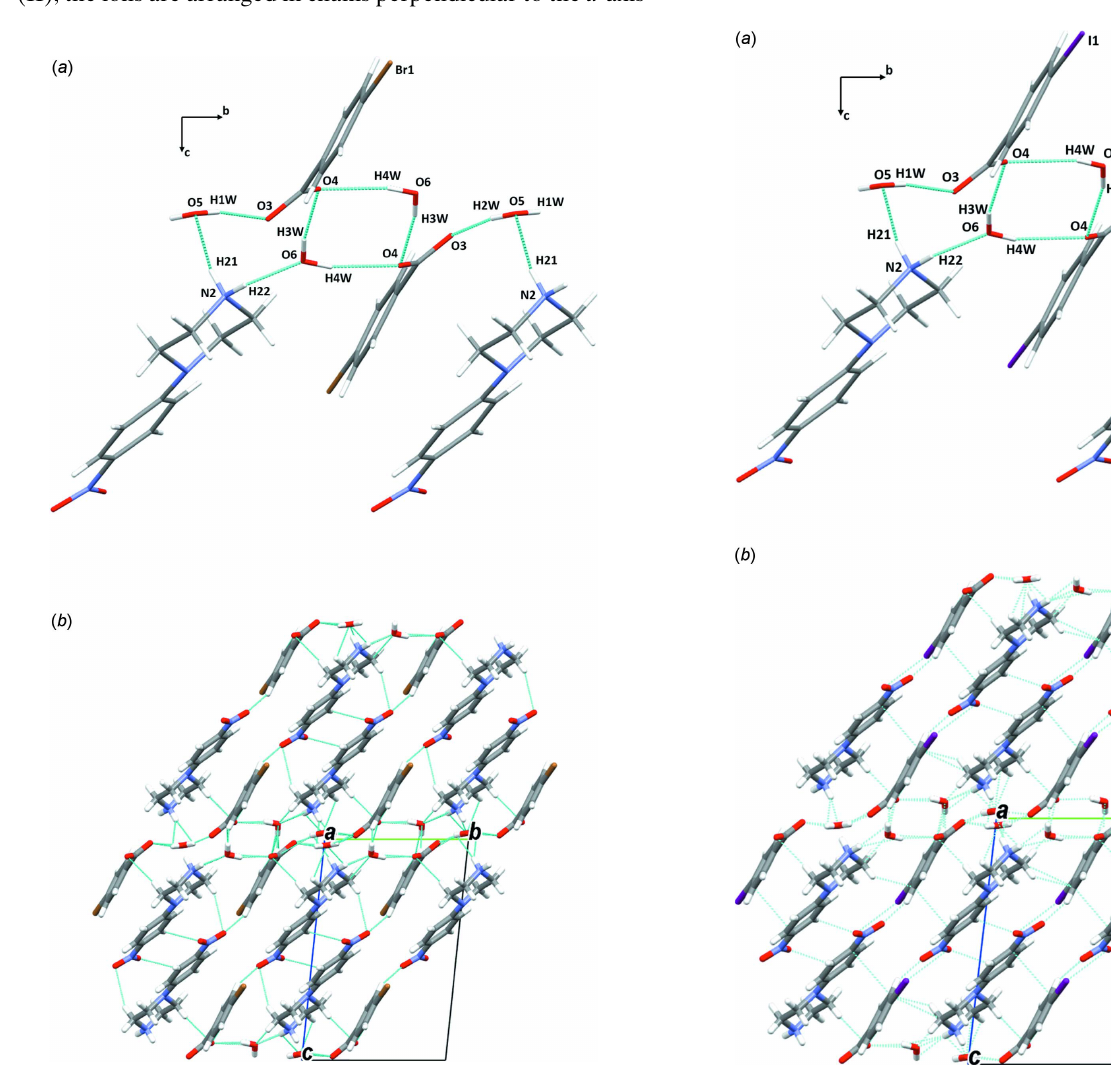
Figure 8 ( a ) A general view of the main intermolecular interactions (N—H (cid:2)(cid:2)(cid:2) O and O—H (cid:2)(cid:2)(cid:2) O) in (II) and ( b ) the molecular packing of (II) with hydrogen bonds shown as dashed lines.